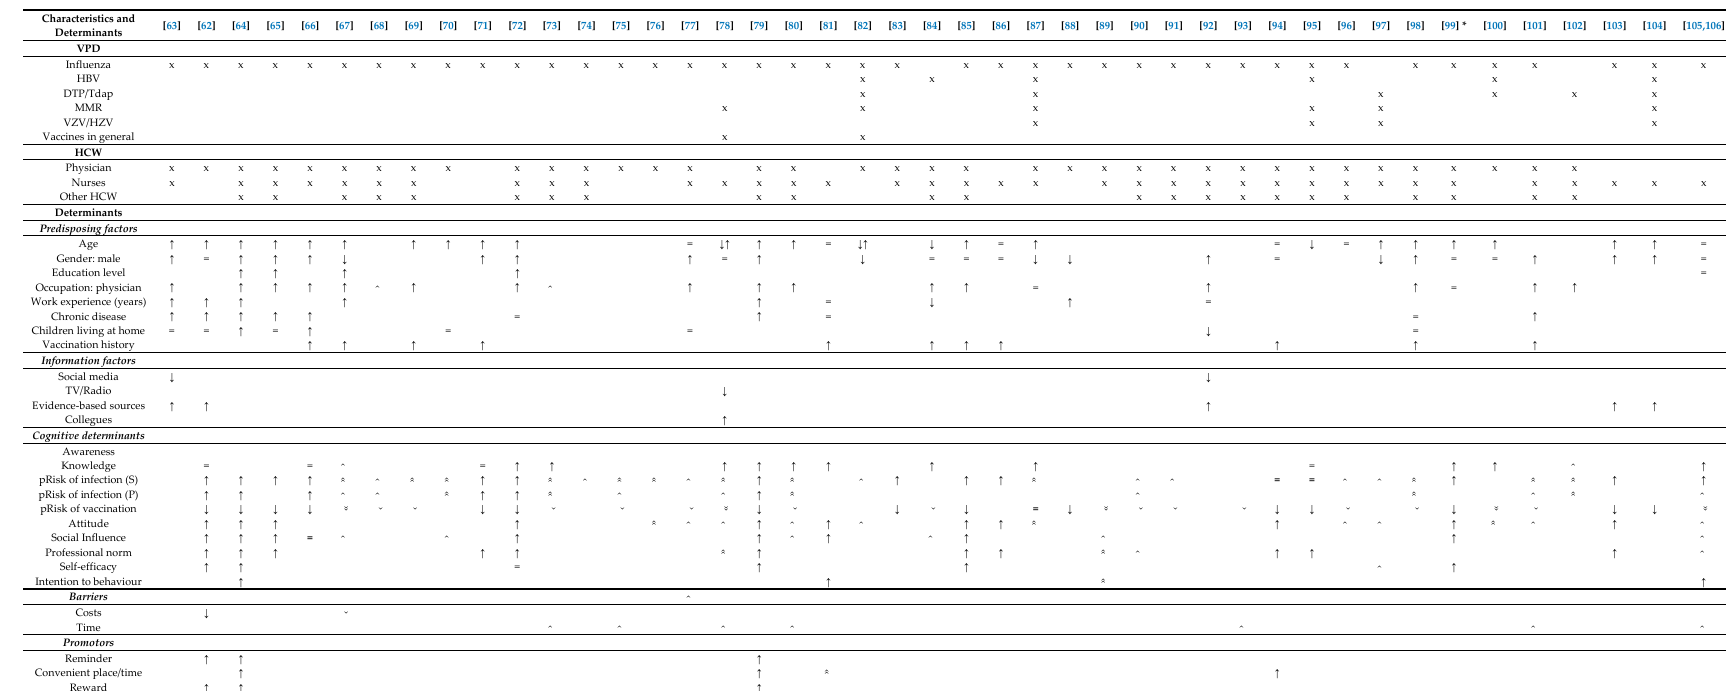
Table 4. Overview of determinants of vaccination uptake in HCW.